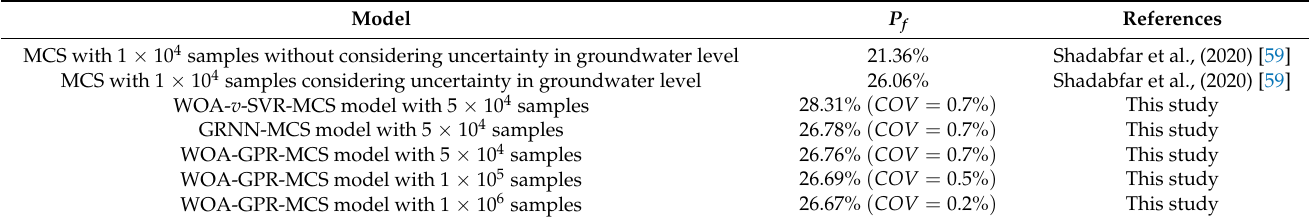
Table 6. Comparison between the dynamic WOA-GPR models with published literature.